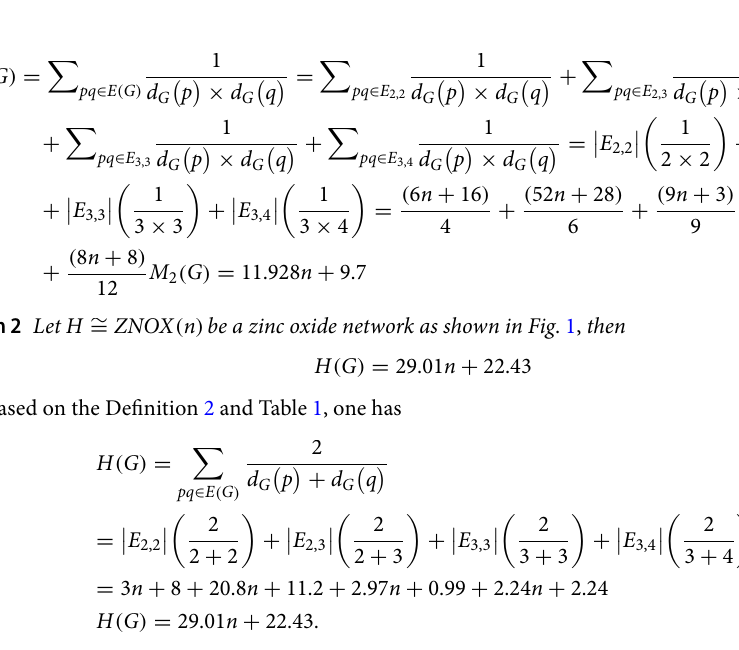
Table 1. Edge partition of ZNOX in relation to the